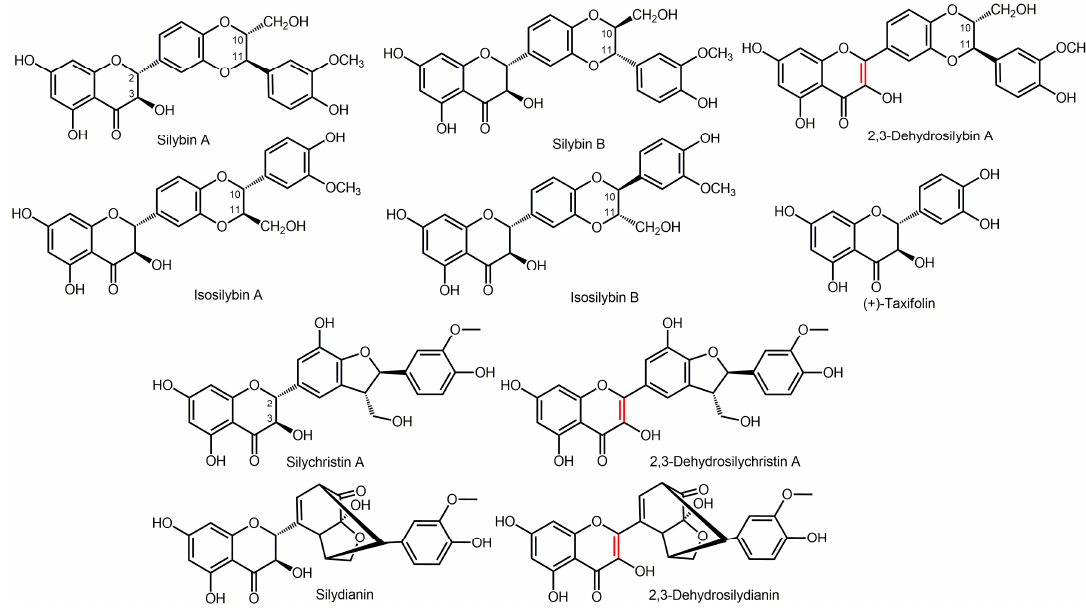
Figure 1. Structures of (selected) silymarin components.